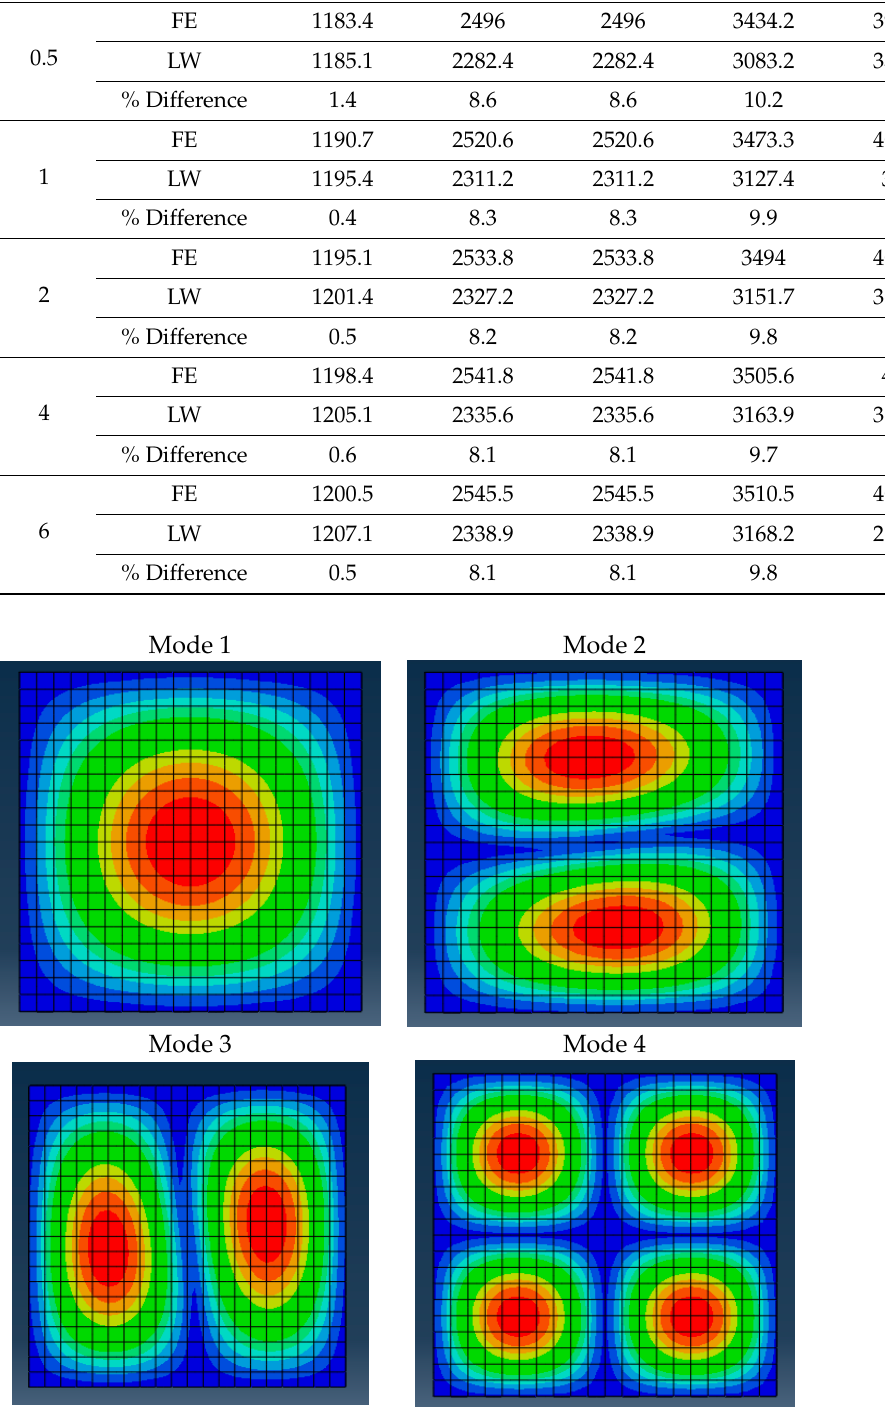
Figure 4. First four mode shapes of the square sandwich plate ( a/h = 20) in ABAQUS.